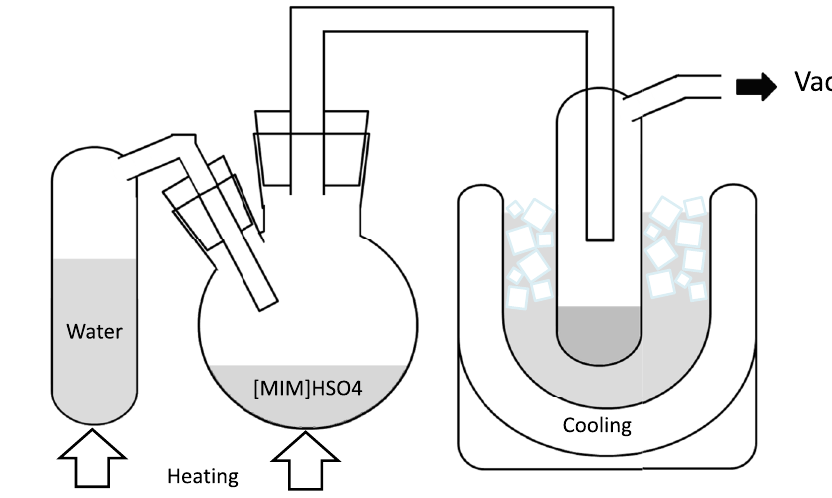
Figure 6. Overview of the vacuum steam distillation system used with [MIM]HSO 4